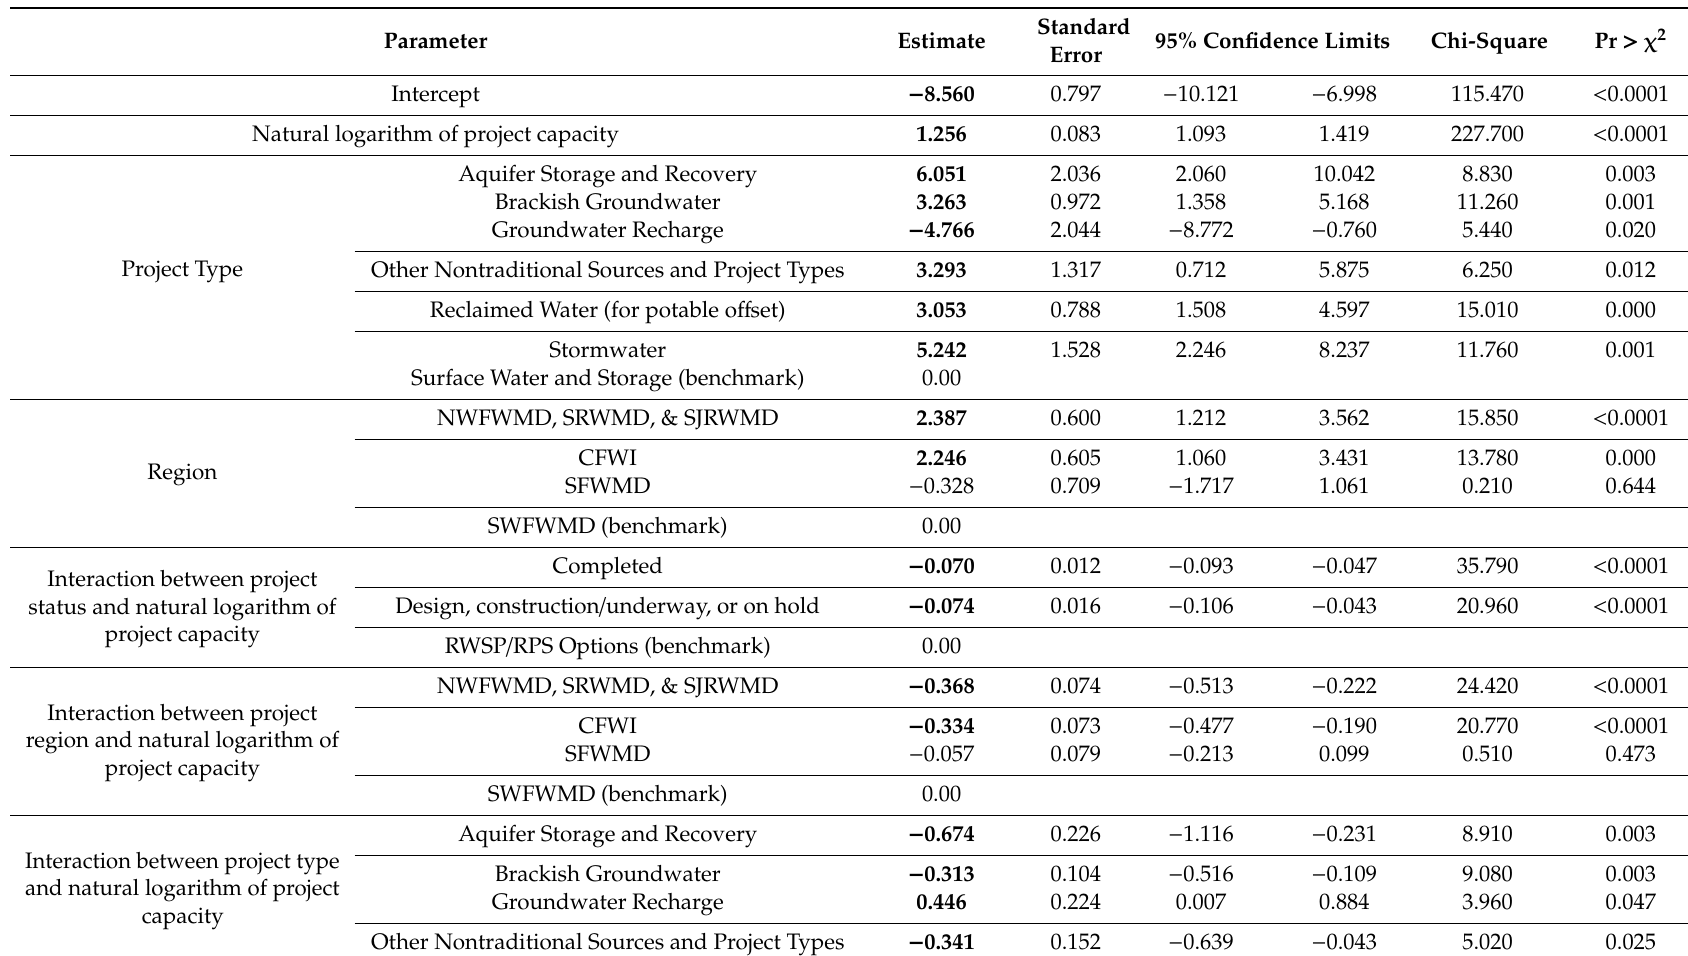
Table 6. Estimated coe ffi cients for the variables used in the regression model (with the coe ffi cients that are statistically di ff erent from zero highlighted in bold